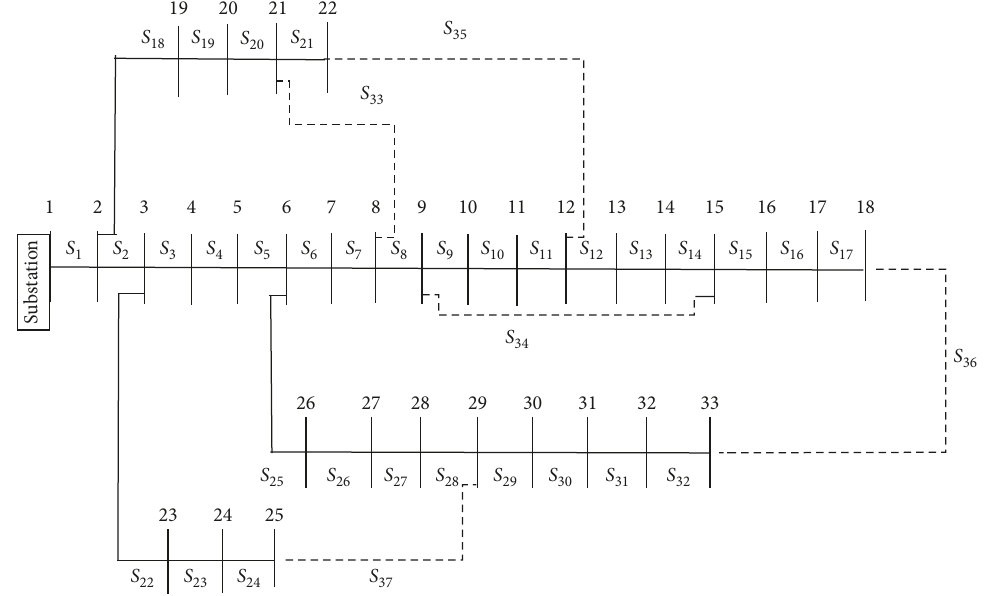
Figure 1: Single-line scheme for 33-bus